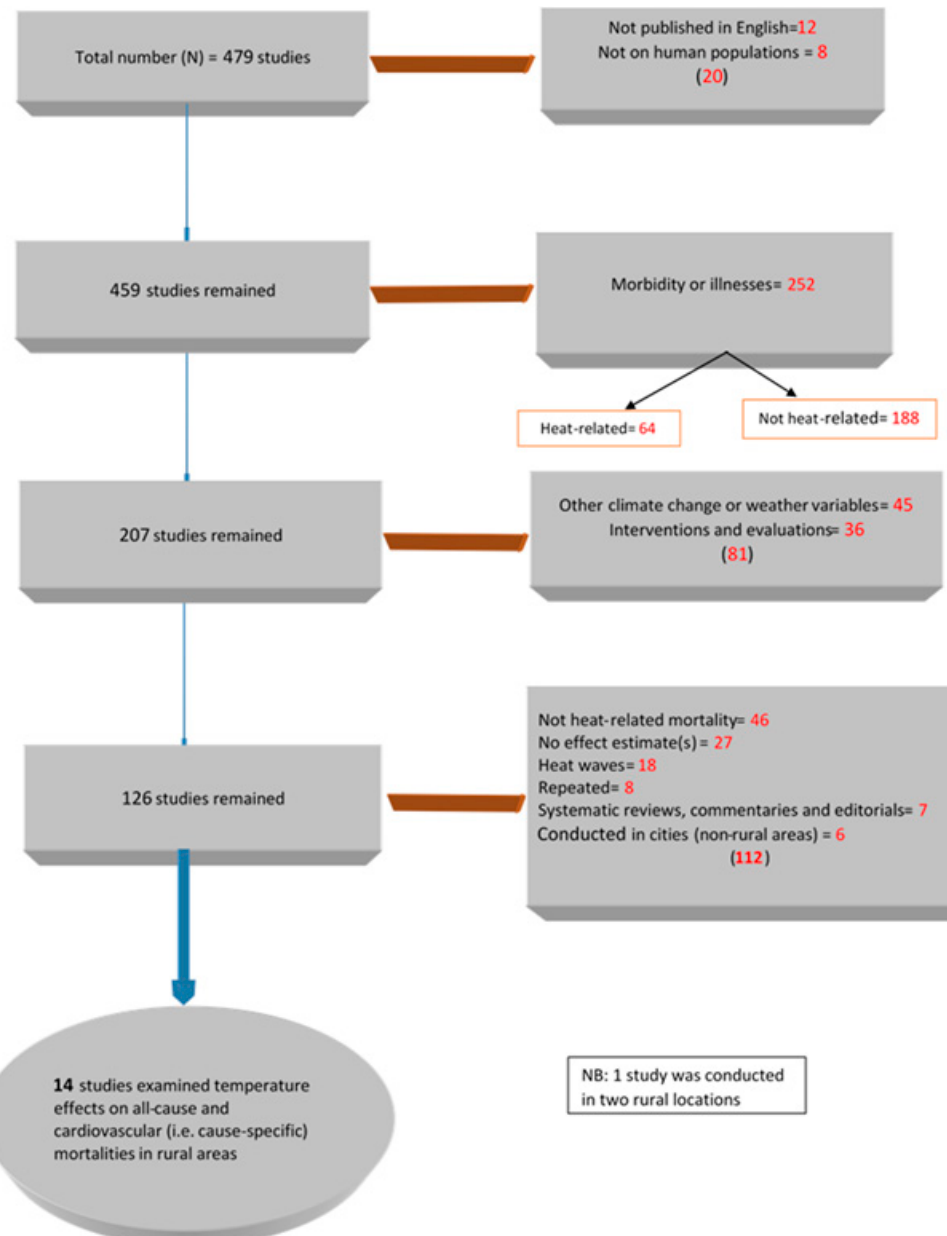
Figure 1. Flow chart illustrating study selection.